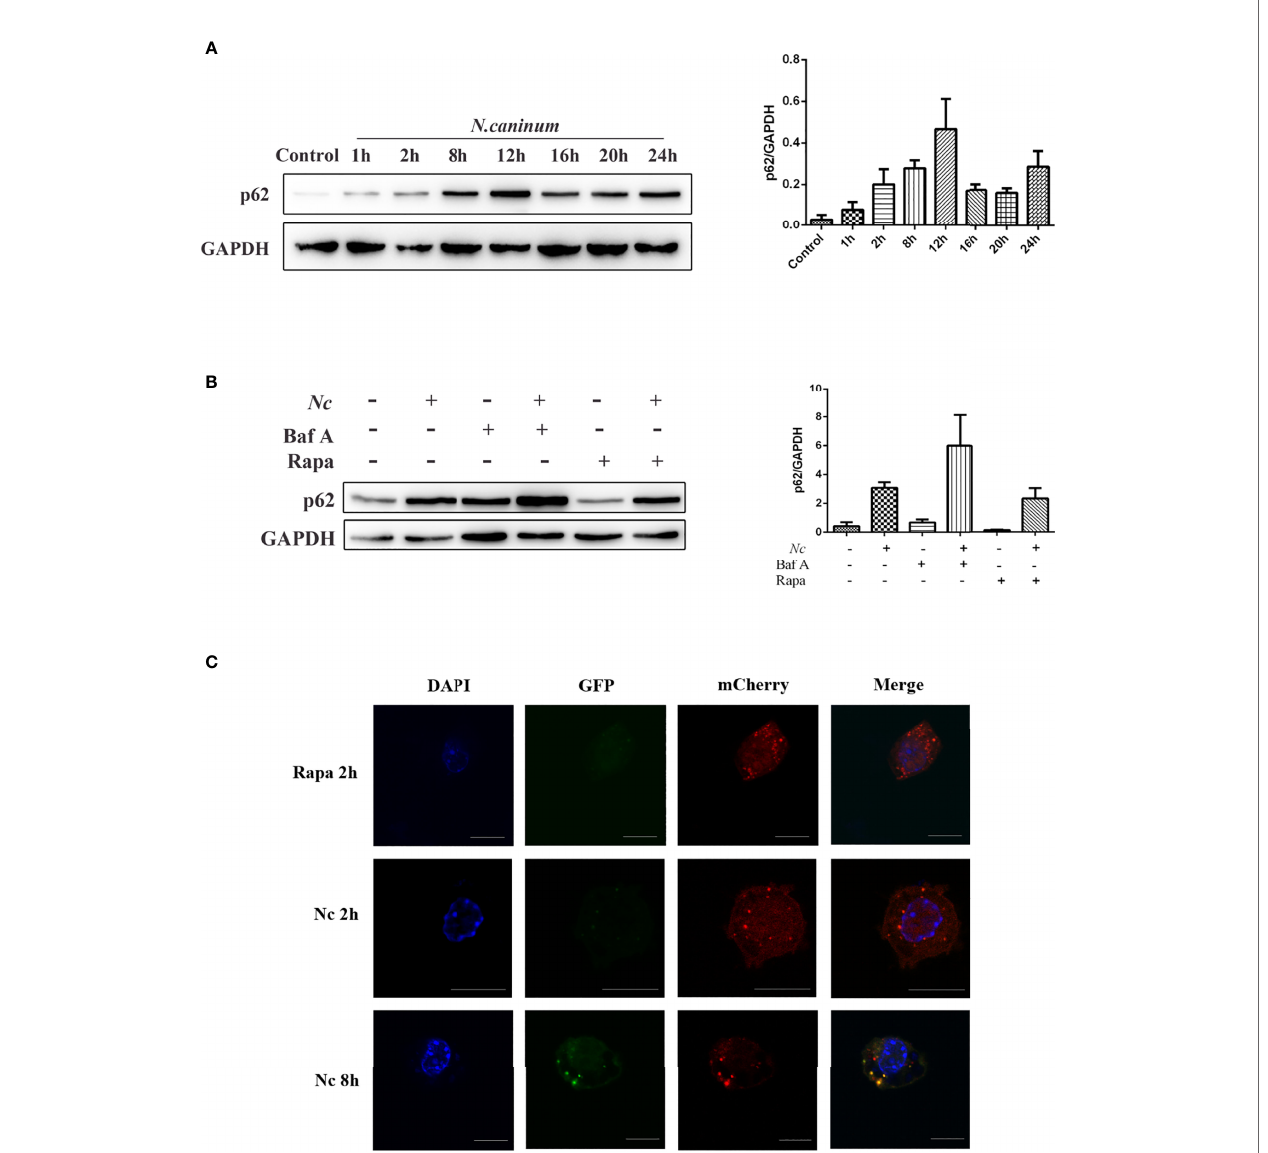
FIGURE 2 | Neospora caninum infection suppresses autophagic fl ux. The changes in p62 were determined by Western blot analysis. (A) Peritoneal macrophages were infected with N. caninum tachyzoites (MOI = 3), and total protein was extracted after 0, 1, 2, 4, 8, 12, 16, 20, and 24 h, respectively. (B) Peritoneal macrophages were pretreated with rapamycin (1 m M) or ba fi lomycin A (100 nM) for 1 and 4 h and then infected with N. caninum tachyzoites (MOI = 3:1, parasite: cell). (C) RAW264.7 cells were transfected with mCherry-GFP-LC3, and cells treated with 1 m M rapamycin for 2 h were used as the positive control for the induction of autophagy. At 2 and 12 h postinfection, the cells were fi xed and assessed for GFP and mCherry fl uorescence. Scale bars: 10 m m. One of the three experiments conducted is